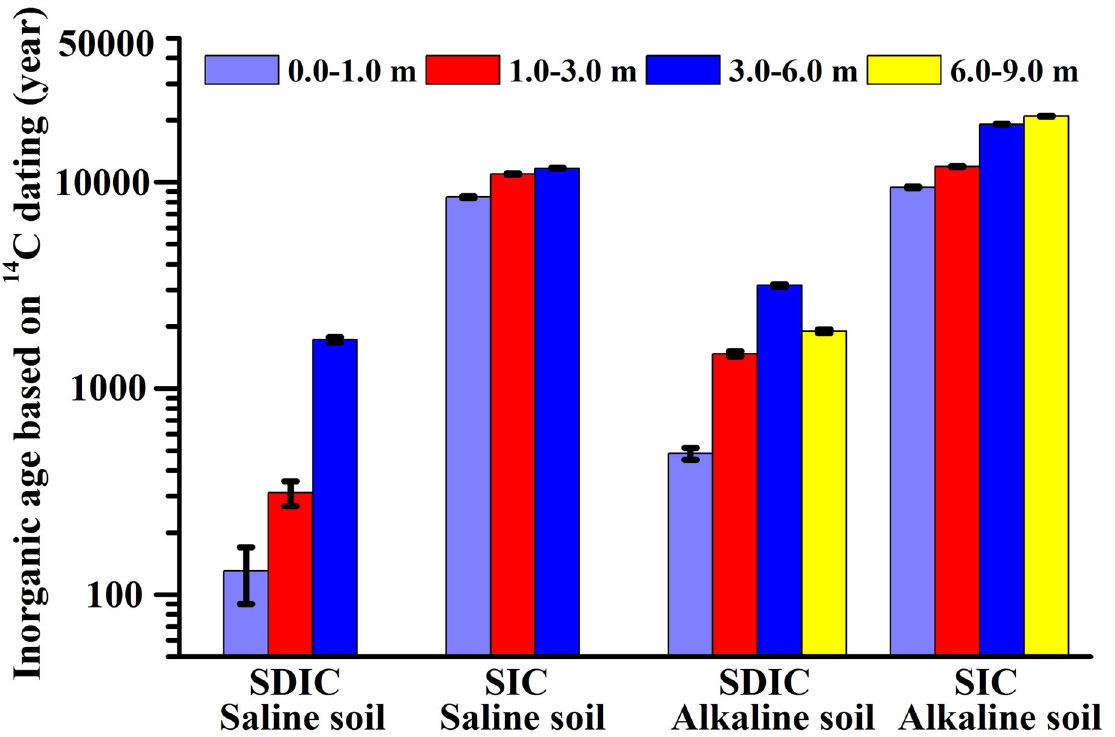
Figure 4. Mean residence times of SIC and SDIC and standard error at different soil layers in the saline and alkaline soil